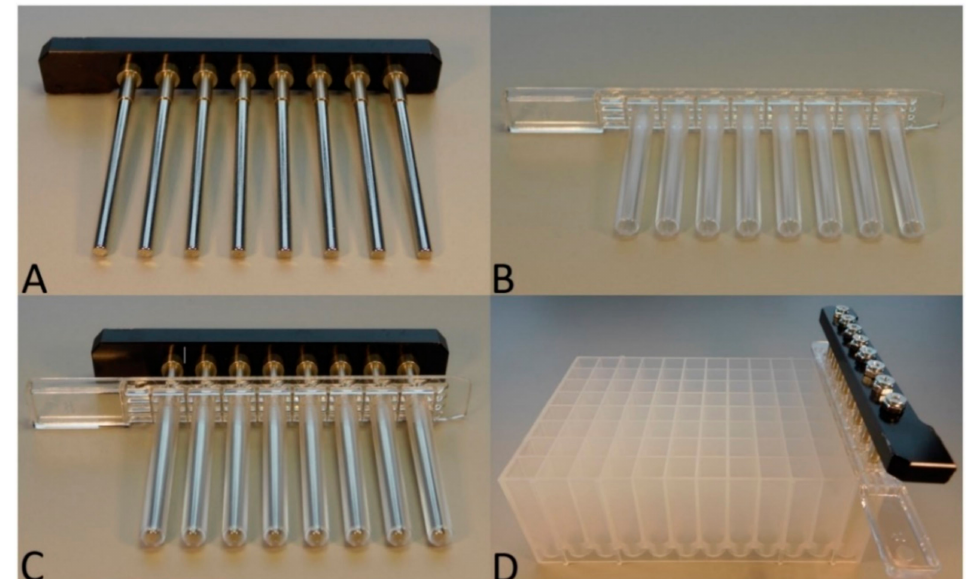
Figure 1. Materials used for the Triple E system. ( A ) In-house-self-made magnetic 8-channel. ( B ) In- diMag 48 PW Rod cover. ( C ) Magnetic channel combined with rod cover. ( D ) Magnetic-tip comp inserted into the park position in column 12 of the IndiMag 48 PW 24- Sample